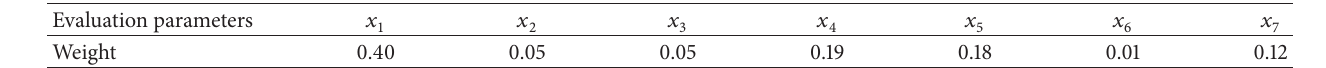
Table 4: The weight of every evaluation parameter.